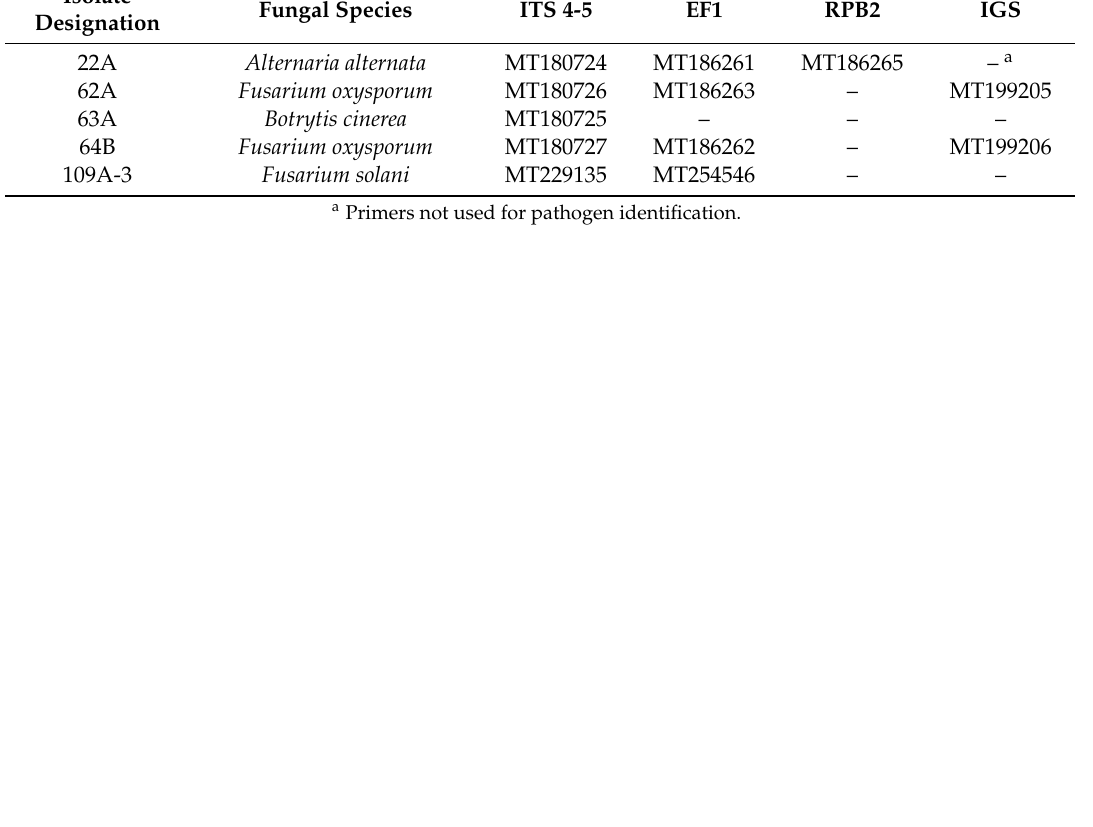
Primers Used for Fungal Identification with Corresponding Accession Numbers